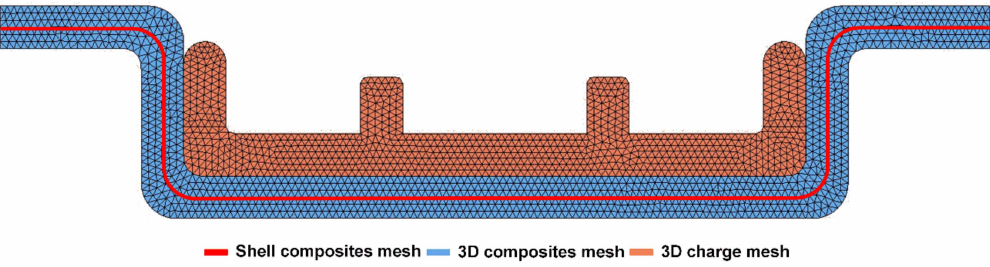
Figure 4. The dual mesh method of